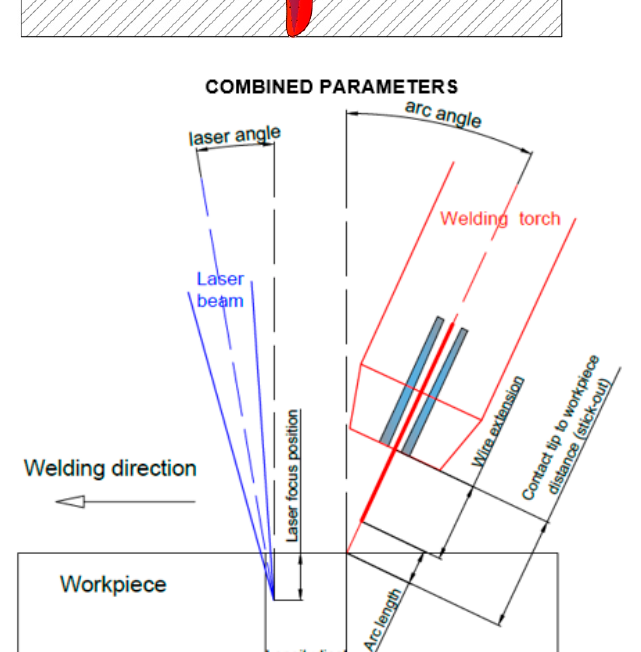
Figure 7. Shape of MIG/MAG weld beads in butt joints: ( a ) convex and ( b ) concave welding.